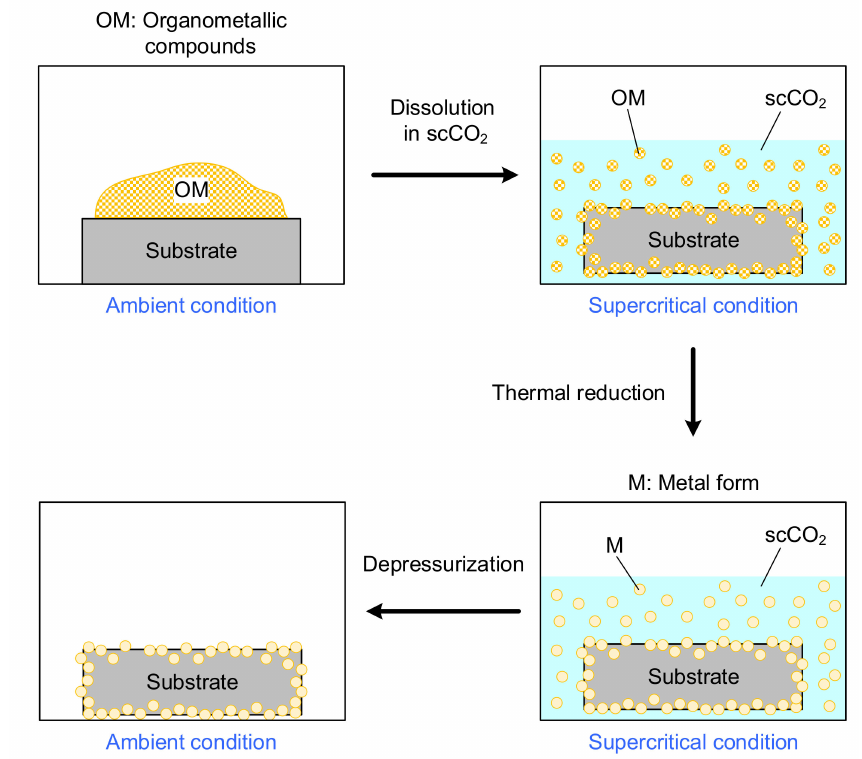
Figure 2. Schematic representation of the supercritical CO 2 deposition